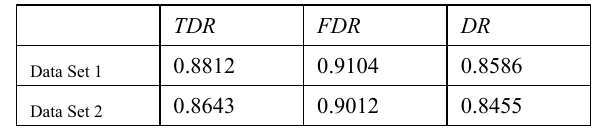
Table 1. Quantitative evaluation of Data Set 1 and Data Set 2.